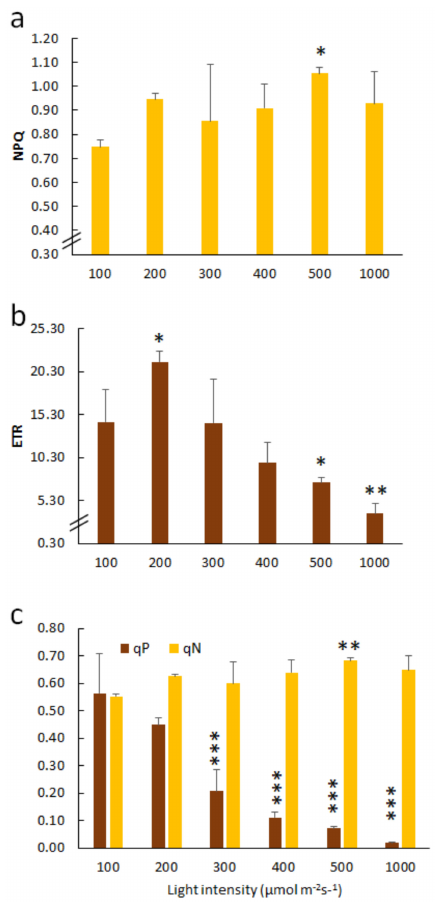
Figure 1. Light response curves of the chlorophyll fluorescence parameters of the moth orchid. ( a ) Non-photochemical quenching (NPQ), ( b ) electron transport rate (ETR), ( c ) photochemical quenching of fluorescence (qP) and non-photochemical quenching of fluorescence (qN) of orchids. Young seedlings were used in this experiment. A significant di ff erence when compared to the “100 µ mol m − 2 s − 1 ” is indicated with an asterisk. Statistical significance was determined by a one-way analysis of variance (ANOVA), followed by a Dunnett’s test. *, p < 0.05; **, p < 0.01; ***, p < 0.001. Error bars represent the standard error of the mean ( n =